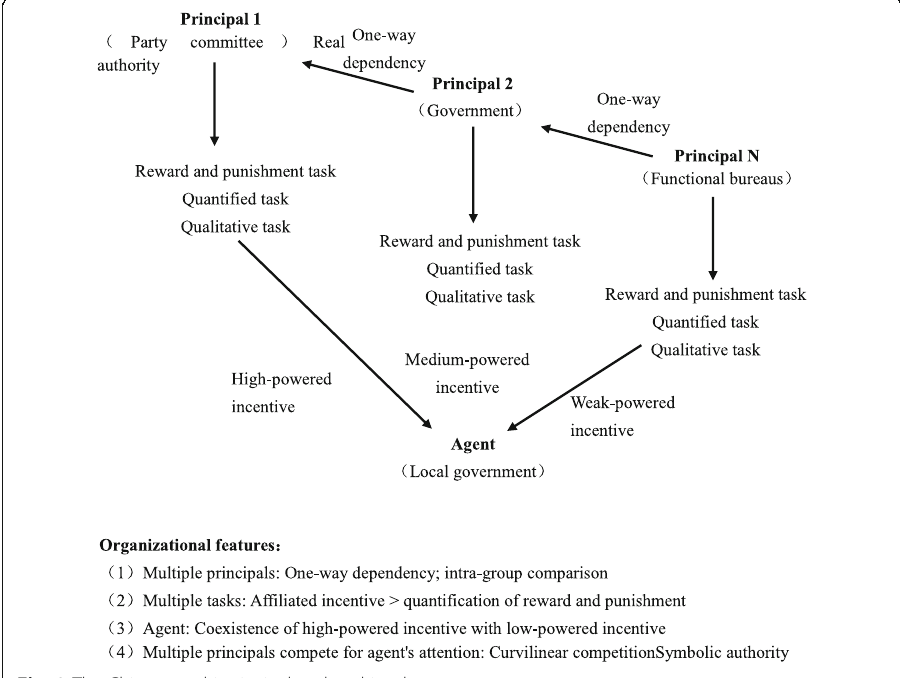
Fig. 3 The Chinese multi-principal and multi-task